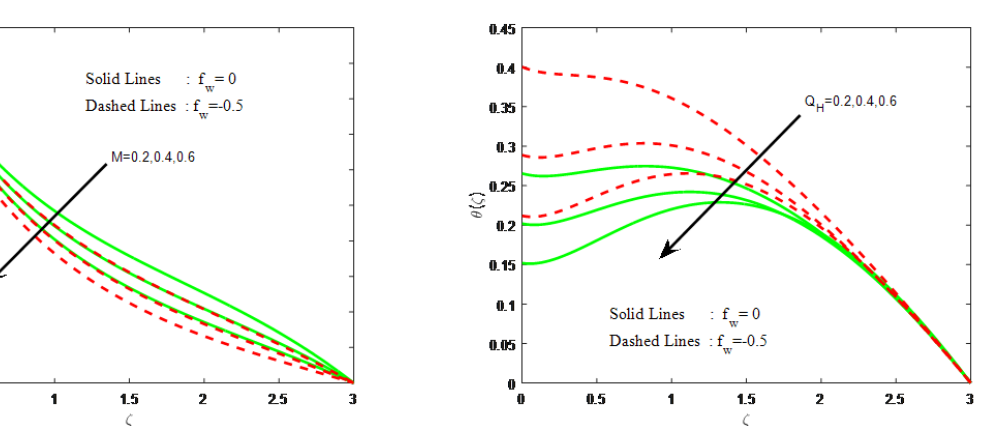
Fig. 5: The effect of heat source parameter Q H on temperature field